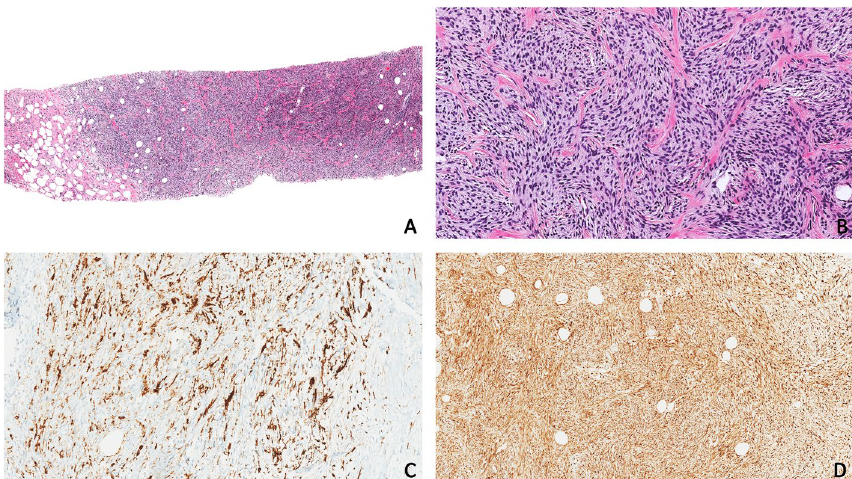
Fig. 2 BCOR HG-ESS from breast needle core biopsy. A H&E section of breast needle core biopsy with metastatic BCOR HG-ESS at 40X magnification, showing moderately cellular spindle cell lesion with no normal mammary parenchyma. B H&E section of breast needle core biopsy with metastatic BCOR HG-ESS at 200X magnification, showing a mitotically active, spindle-cell lesion arranged in short fascicles within a predominantly fibrous stroma. C CD10 immunohistochemistry at 200X magnification. Note cells with strong/diffuse expression admixed with those with negative expression. D Cyclin D1 immunohistochemistry showing strong/diffuse expression at 100X